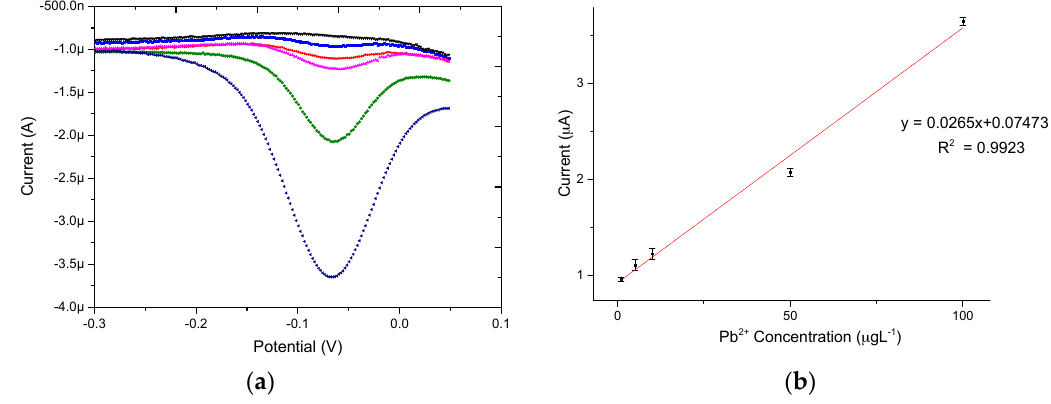
Figure 6. ( a ) DPSV responses of the PPy/MWCNT/Au for the detection of different concentrations of Pb 2+ (from 1 to 100 μ g·L − 1 ) in 0.1 M HCl; and ( b ) the corresponding linear calibration plots of stripping peak currents for Pb 2+ .